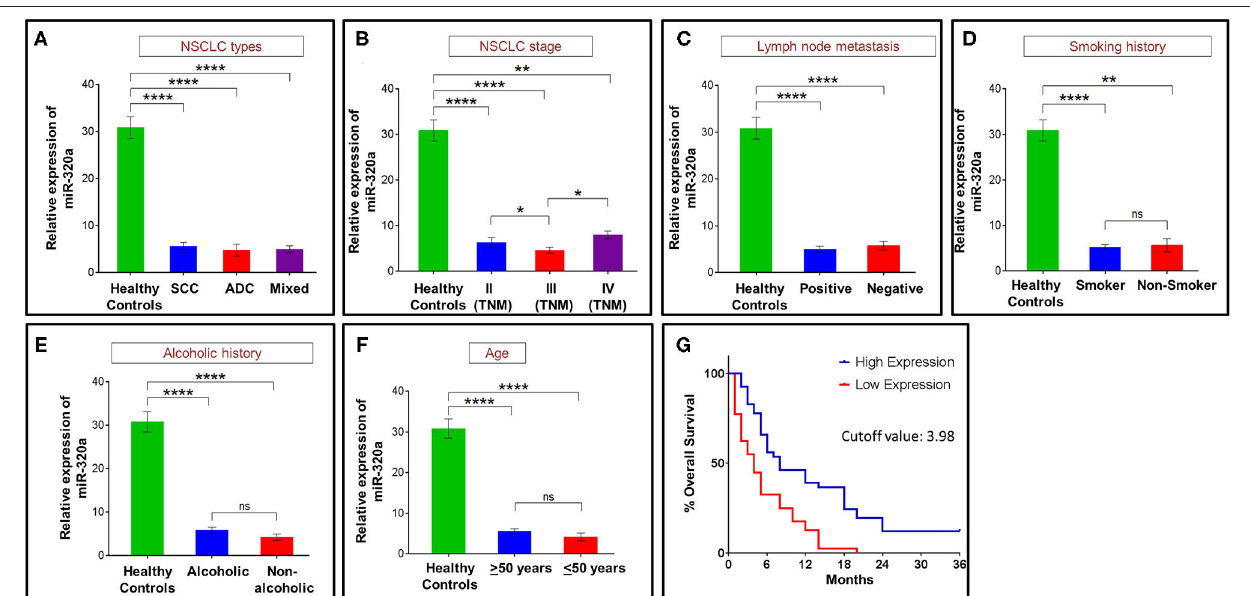
FIGURE 2 | Circulating miR-320a expression correlated with NSCLC patient prognosis. (A) NSCLC histological types. (B) NSCLC stage. (C) Lymph node metastasis status. (D) NSCLC patients smoking history. (E) Alcoholic history of NSCLC patients. (F) Age of NSCLC patients. Bar graphs represent the relative expression of circulating miR-320a from at least n = 3 independent experiments. The data are expressed as mean ± SEM where * p < 0.05, ** p < 0.01, *** p < 0.001, and **** p < 0.0001 calculated using unpaired and paired t- test. (G) Kaplan-Meier survival test to determine a correlation between percent overall survival and the circulating miR-320a expression of NSCLC patients. The median expression values of circulating miR-320a in NSCLC patients of 3.98 were used as the cutoff for high and low expression groups [TNM, tumor node metastasis; SCC, squamous cell carcinoma; ADC,